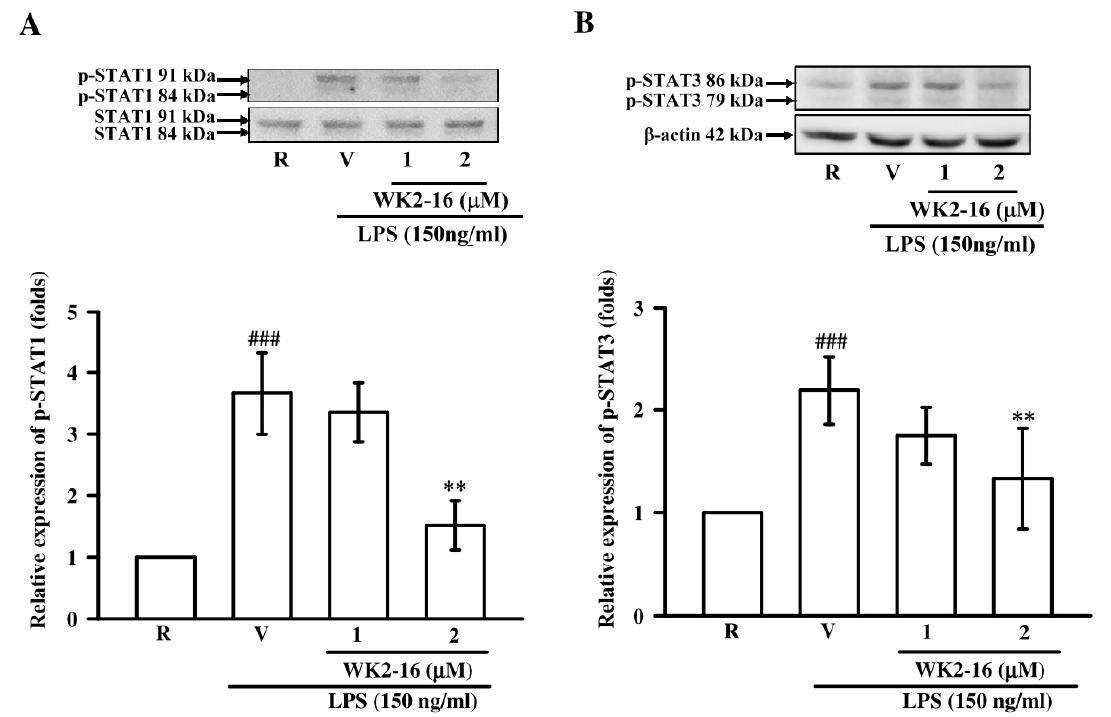
Figure 6. WK2-16 inhibited the activation of STAT-1/-3 in LPS-stimulated microglial BV-2 cells. Microglial BV-2 cells were pretreated with the vehicle (DMSO) or WK2-16 (1 and 2 µ M) followed by stimulation with LPS (150 ng/mL) for 3 h. Phosphorylated STAT-1 ( n = 3) and STAT-3 ( n = 4) were evaluated using Western blotting. The detection of STAT-1 and β -actin were used as the internal controls. R: resting; V: vehicle; p-STAT1: phosphorylated STAT-1; p-STAT3: phosphorylated STAT-3. ### p < 0.001 compared to the resting group; ** p < 0.01 compared to the LPS-stimulated group treated with vehicle (DMSO).